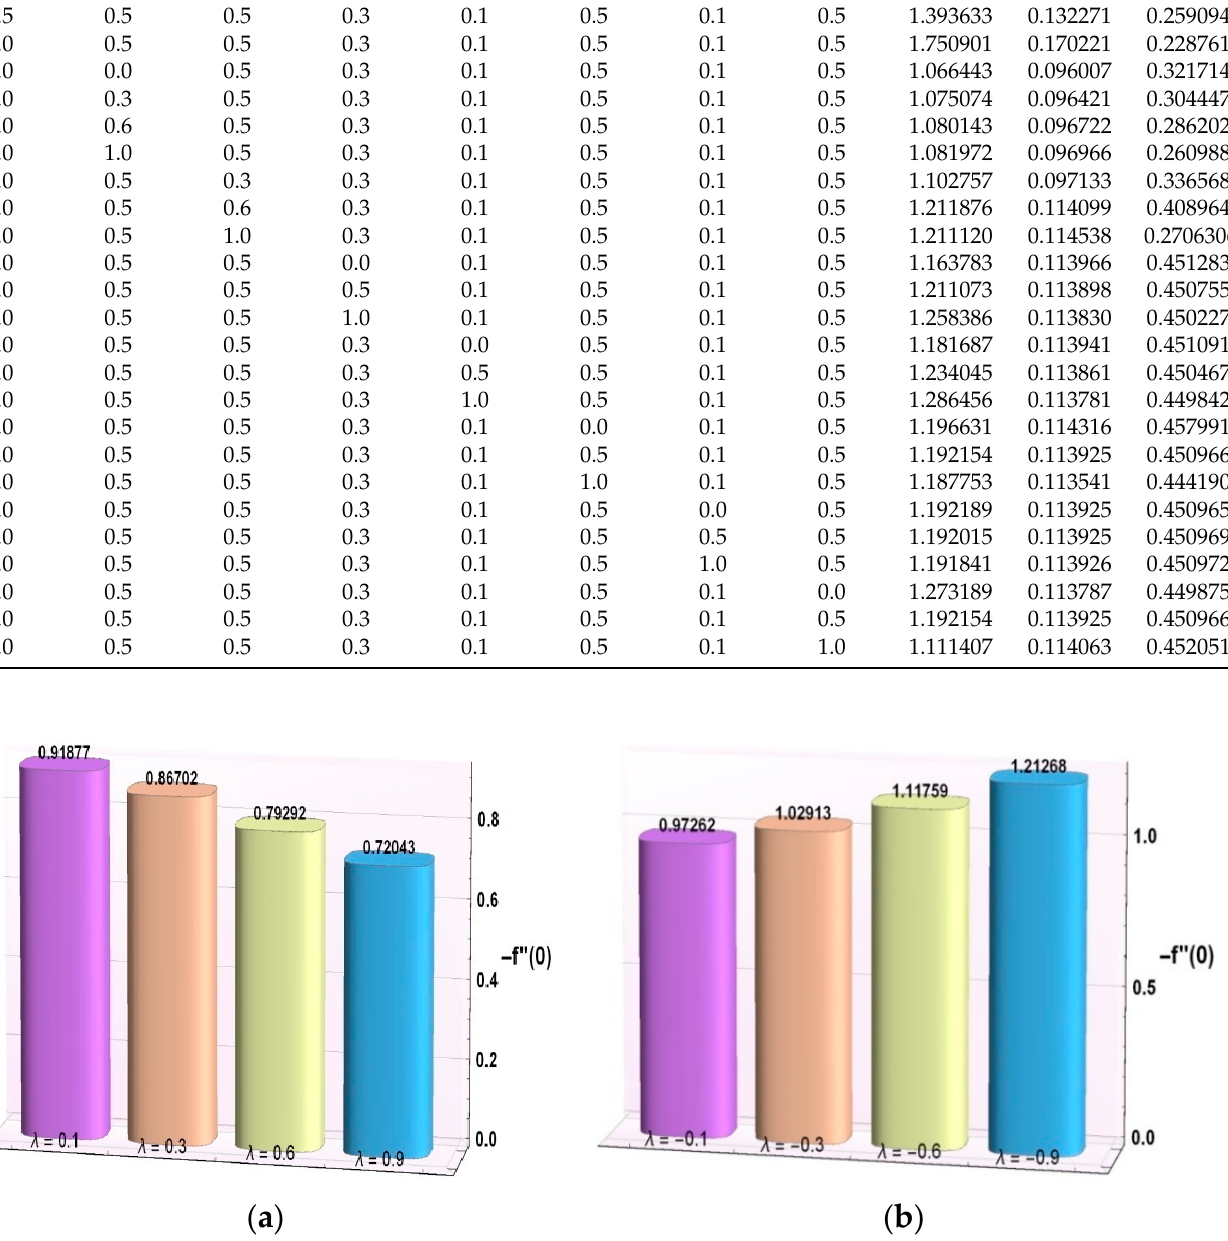
Figure 5. Behavior of ( a ) − f (cid:48)(cid:48) ( 0 ) for λ (cid:31) 0 and ( b ) − f (cid:48)(cid:48) ( 0 ) for λ ≺